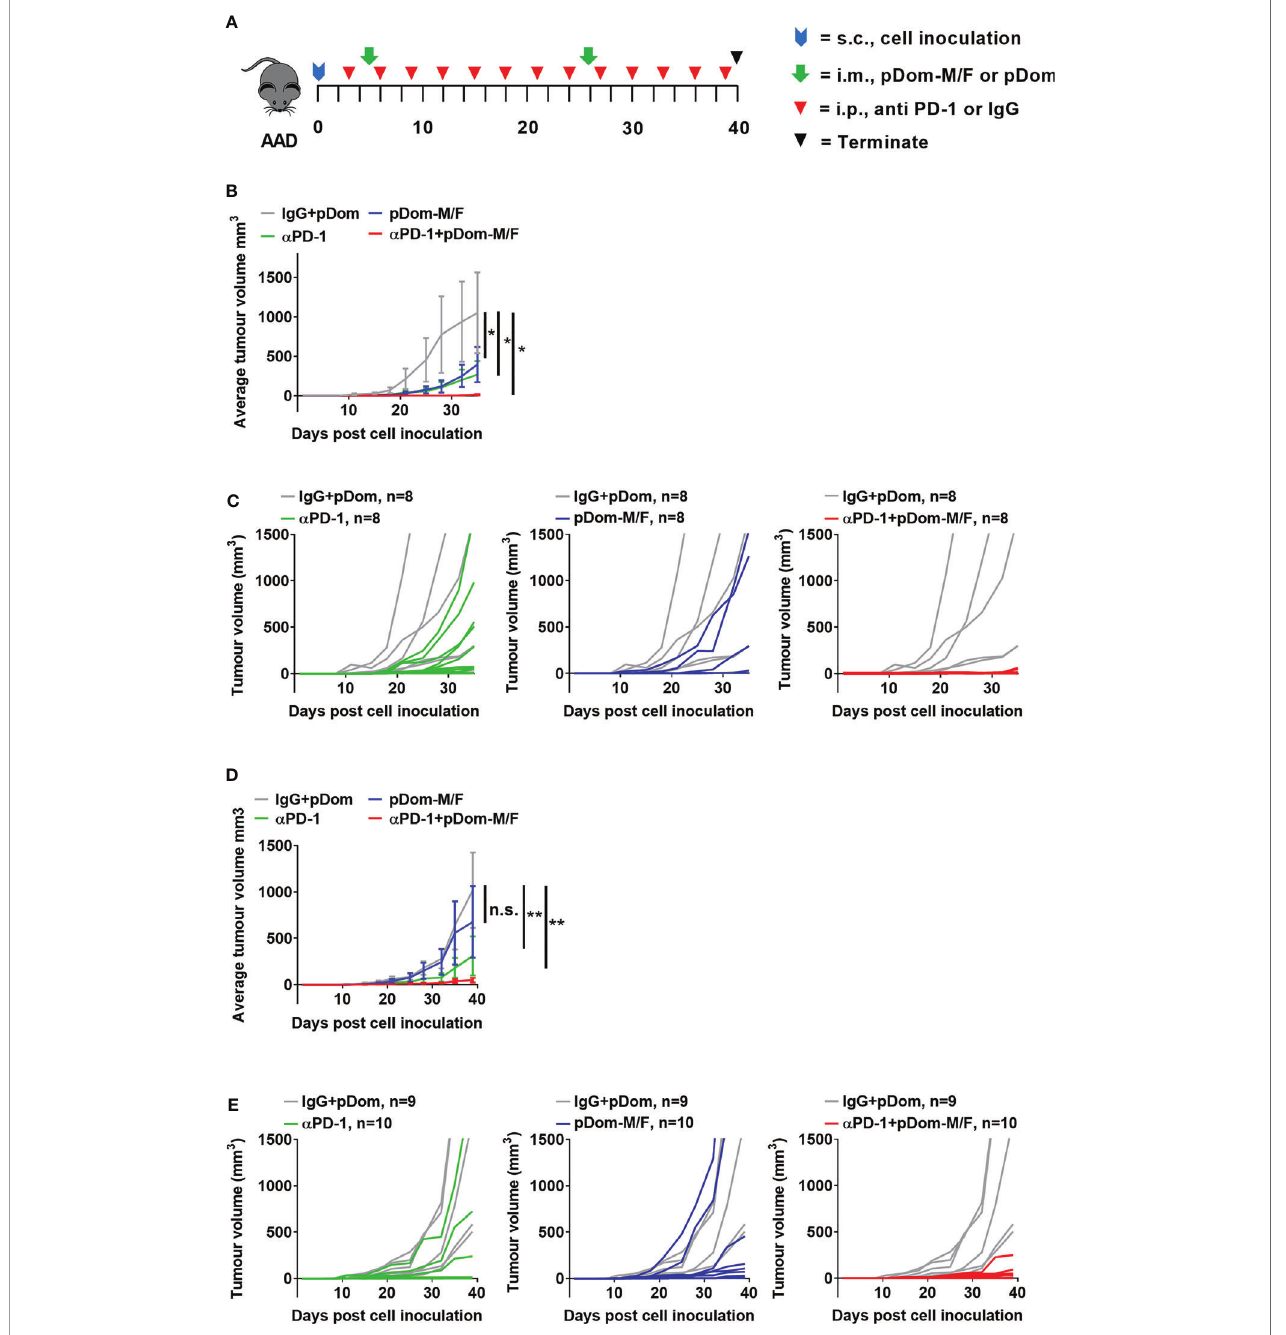
FIGURE 4 | Combination therapy of pDom-M/F and anti-PD-1 inhibited tumour growth in vivo . (A) Schematic of vaccination schedule, mice were inoculated with the BAM or BAF cells and randomized to either received 2 doses of pDom (50 m g per mouse) as vector control combined with 13 doses of isotype control (100 m g per mouse, given every 3 days), 13 doses of anti-PD-1 (100 m g per mouse, given every 3 days), pDom-M/F (pDom-M and pDom-F; 50 m g each vaccine per mouse) and the combination of pDom-M/F with anti-PD-1. Upon termination at end-point, mouse spleens were harvested for ELISpot. (B, D) The graphs indicated mean tumour volumes of treatment group for BAM or BAF model respectively. Statistical analyses were conducted using with two-way ANOVA. (* p < 0.05; ** p < 0.01; ns, not signi fi cant). Statistics represented the comparison on terminated date (day 35 for BAM, day 40 for BAF). (C, E) Graphs of individual animal tumour volumes for BAM and BAF models respectively comparing experimental groups including anti-PD-1 (green line), pDOM-M/F (blue line) and the combination of pDom-M/F with anti-PD-1 (red line) to IgG/pDOM control (grey